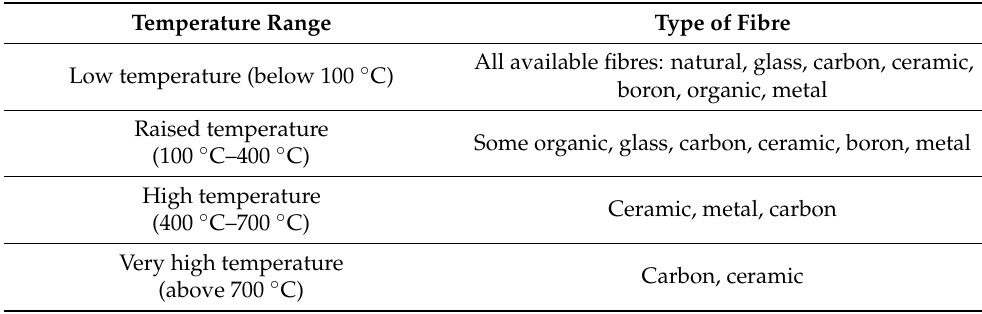
Table 2. Permissible temperatures when using fibres, adapted from